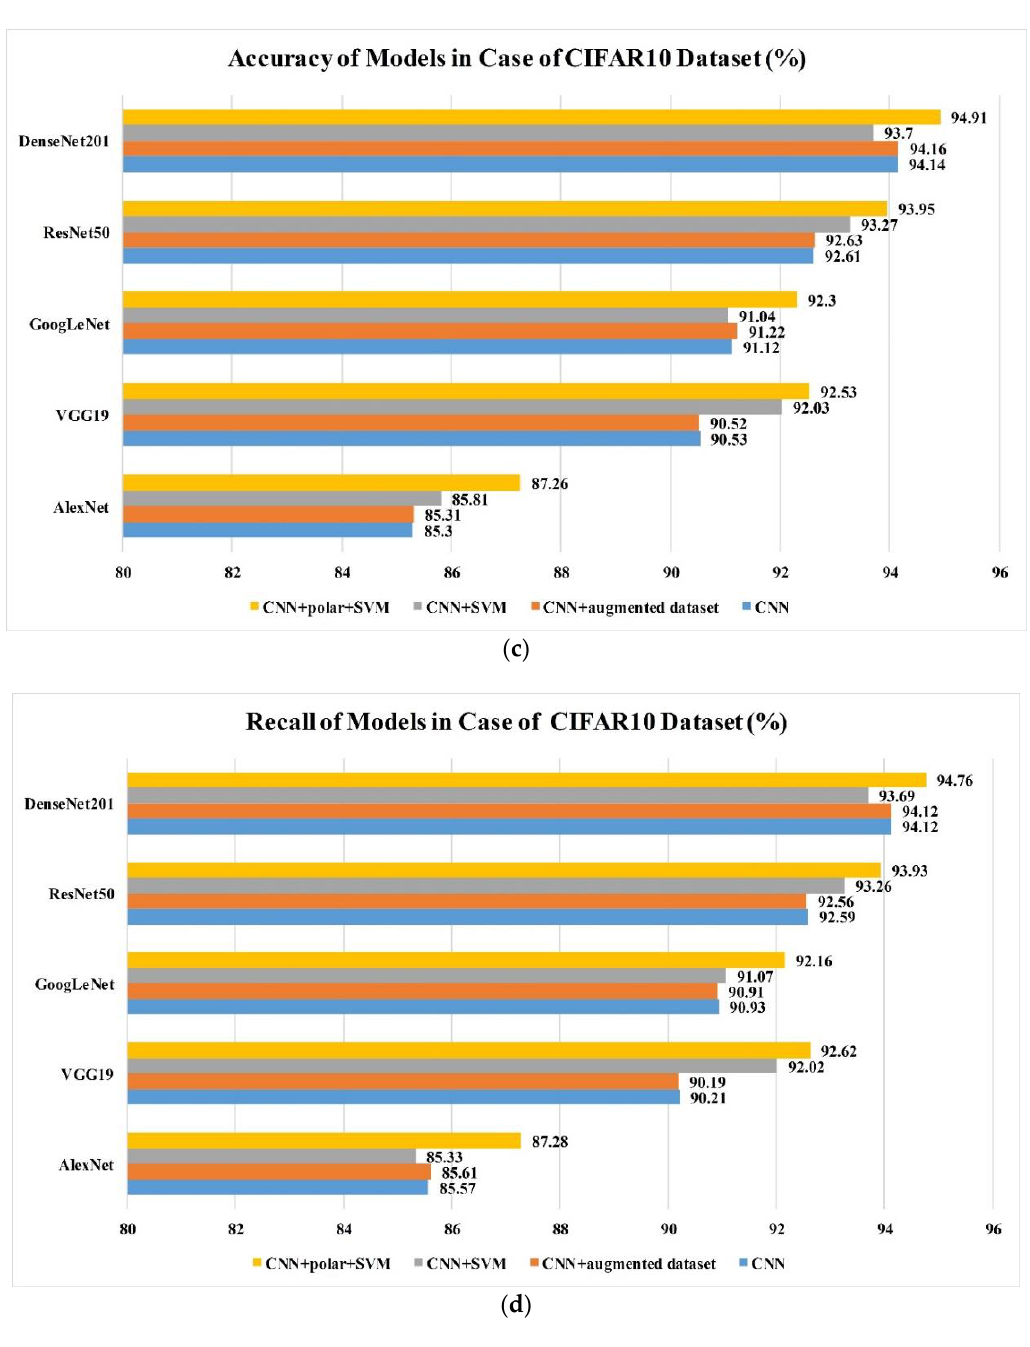
Figure 9. ( a ) Accuracy values of different models obtained using the proposed training method and plankton dataset; ( b ) recall rate values of different models obtained using the proposed training method and plankton dataset; ( c ) accuracy values of different models obtained using the proposed training method and CIFAR-10 dataset; ( d ) recall rate values of different models obtained using the proposed training method and CIFAR-10 dataset.